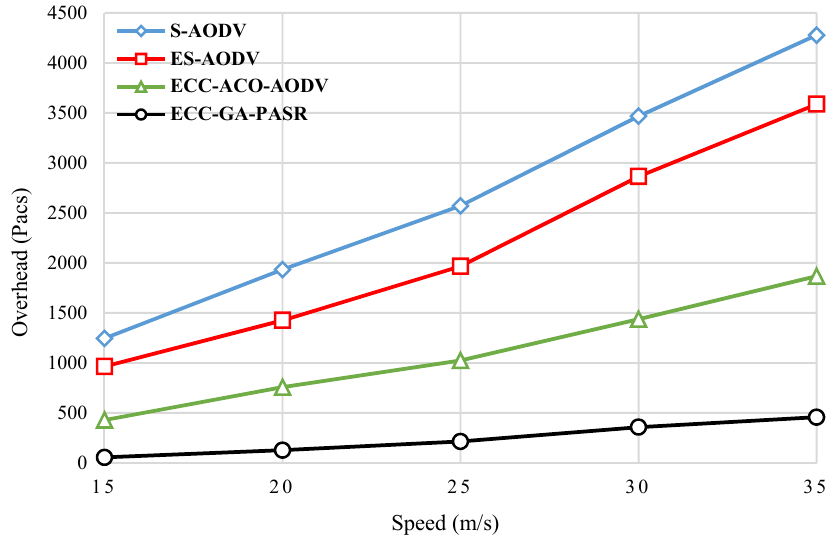
Figure 15. Overhead Calculation based on vary speed of vehicle..